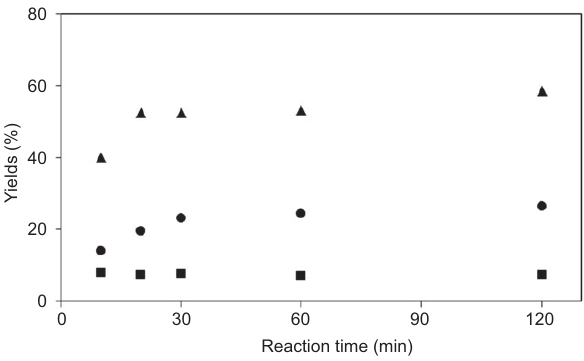
Figure 2 Effect of different types of ILs on the chemical yield of 3-phenylglycidol in the epoxidation reaction of cinnamyl alcohol [3 mol% VO(acac) , 1.5 equiv. TBHP, 25 ° C]: (cid:2) , [bmim][Tf 2